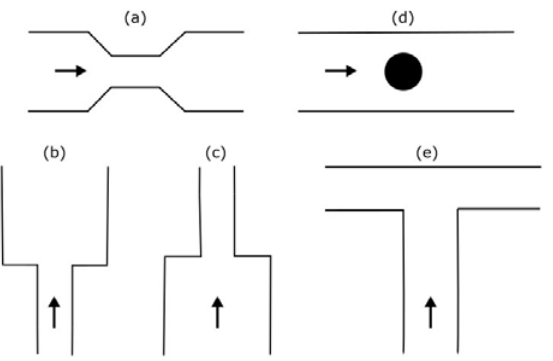
Figure 1. Schematic representation of the most common microfluidic elements: ( a ) constriction; ( b ) expansion; ( c ) contraction; ( d ) obstacle; and, ( e ) T-junction.